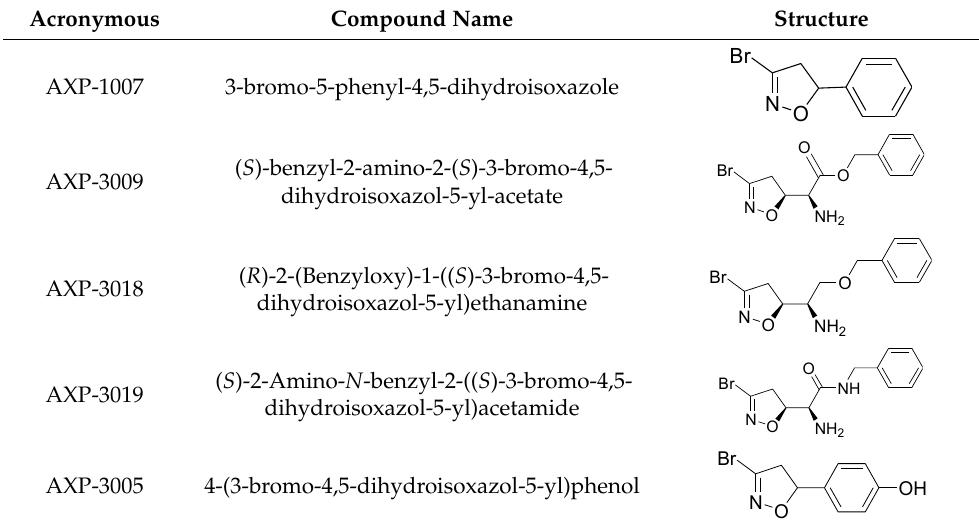
Table 1. The list of 3-bromo-isoxazolines derivatives tested. Acronymous